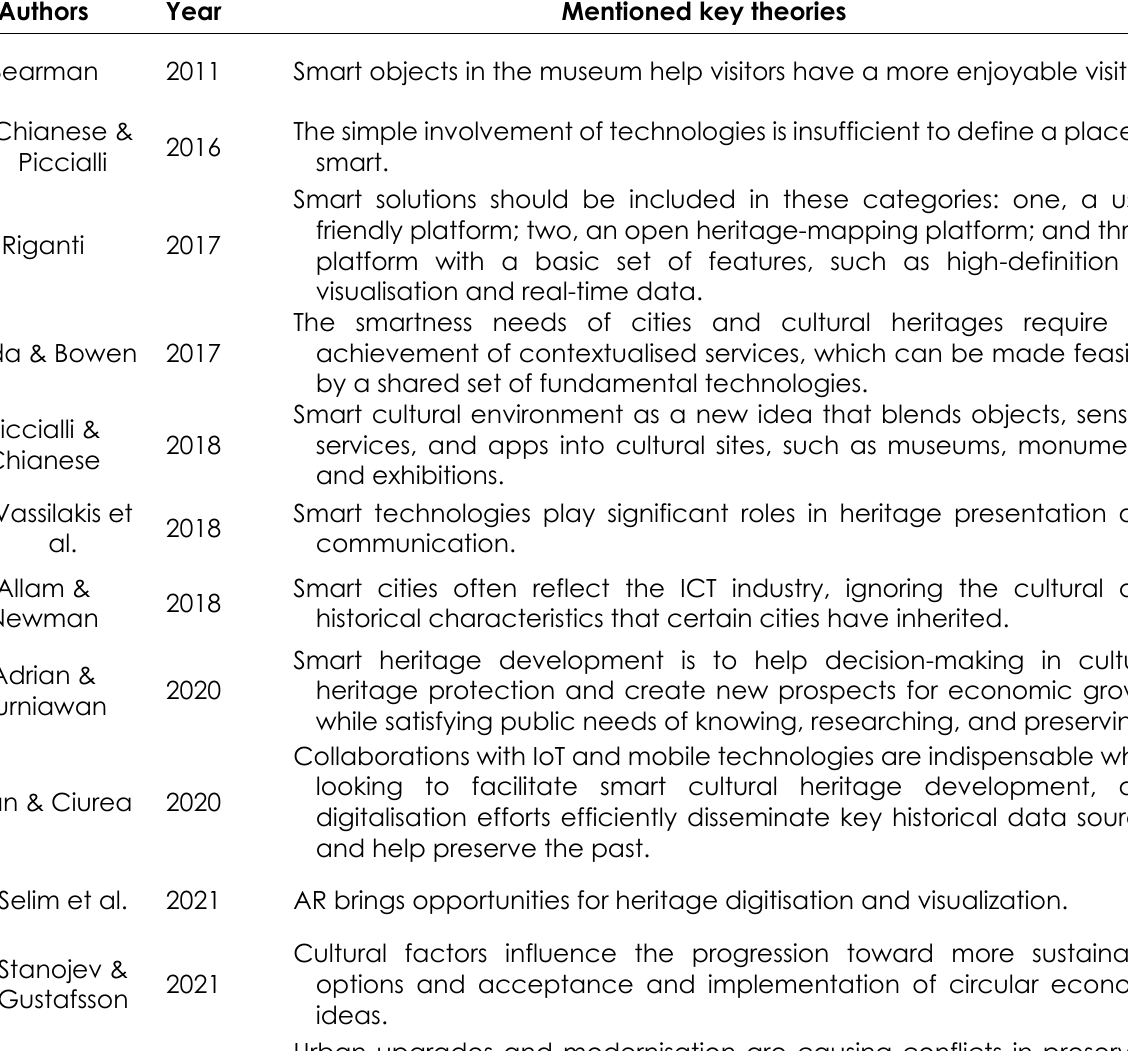
Table 3. Core Theories Contributed by